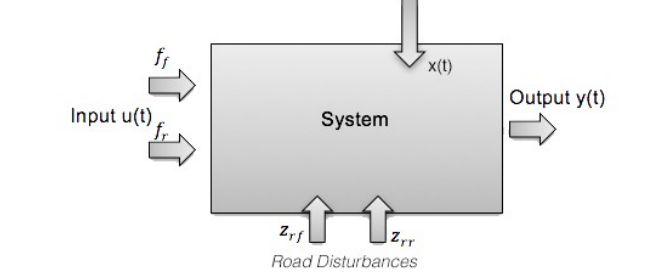
Figure 3. Nonlinear System of Half Car